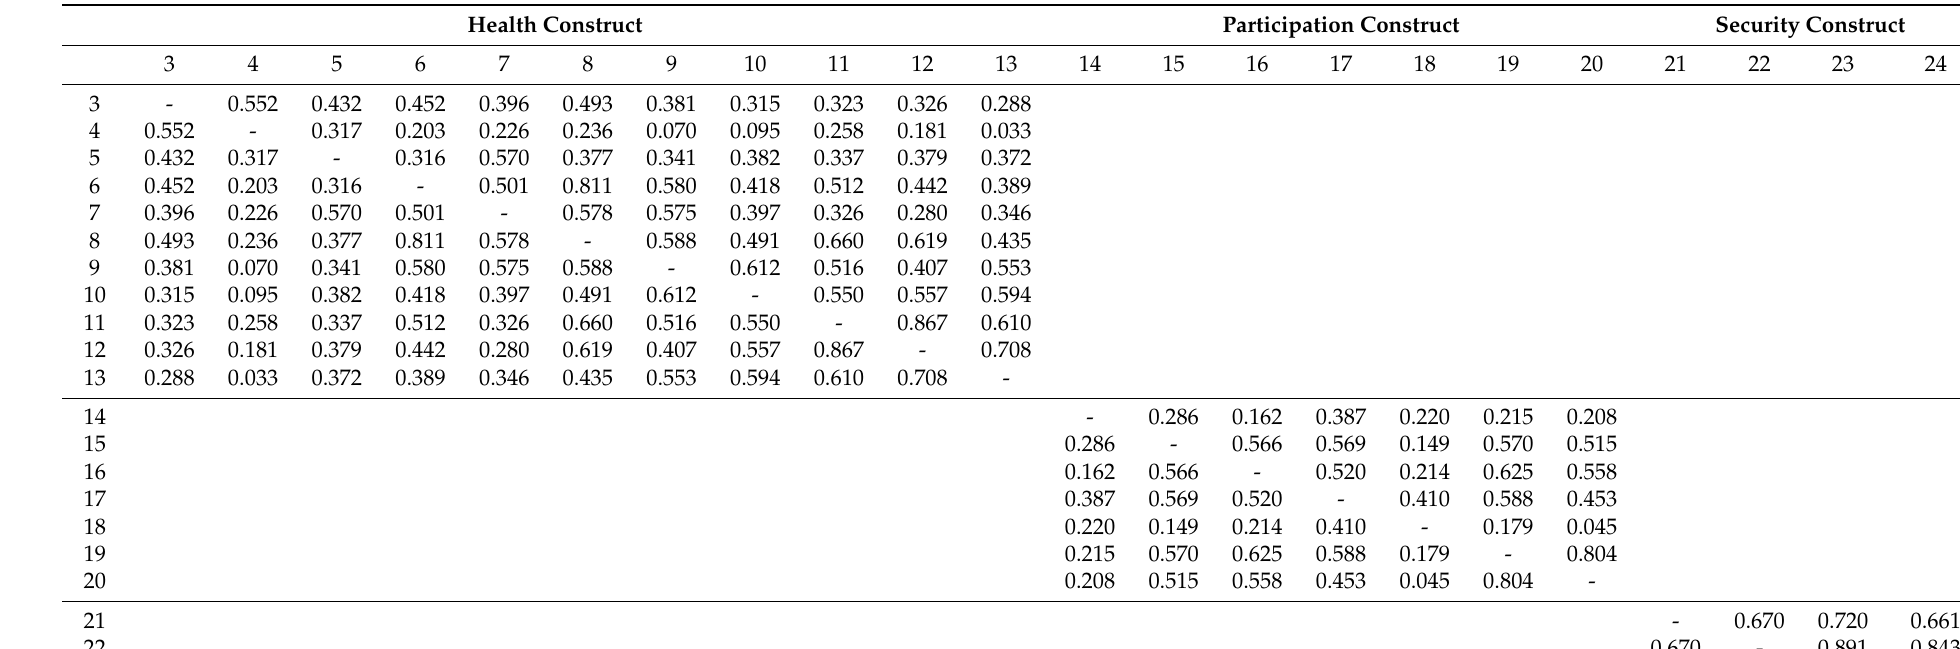
Table 2. The Inter-item Correlation for the constructs in the pilot test (n =